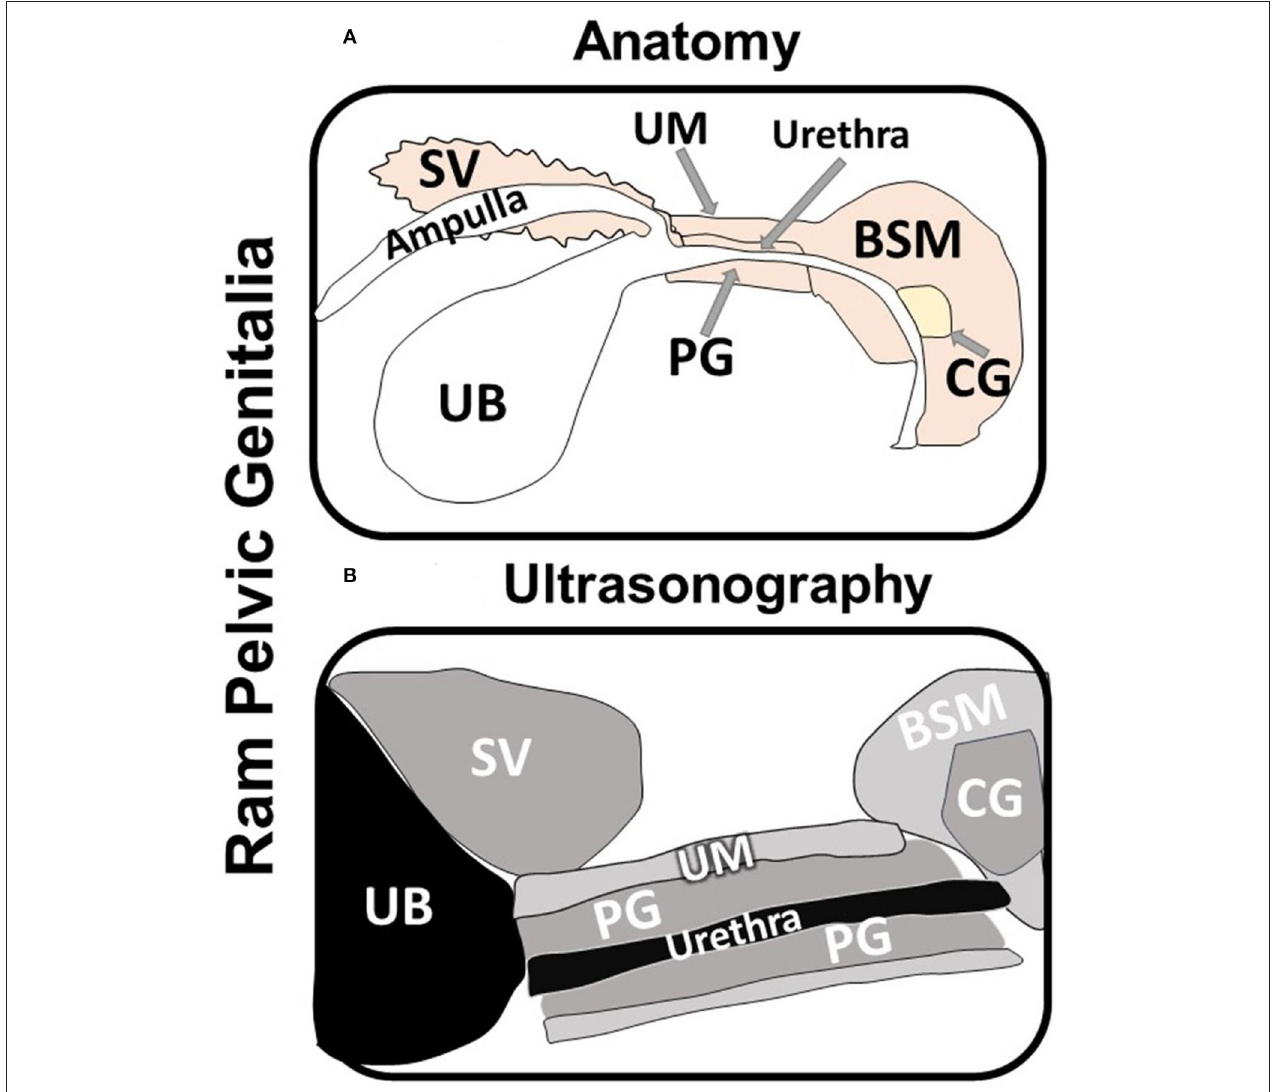
FIGURE 2 | Schematic diagram showing the anatomy (A) and the ultrasonography (B) of the ram intra-pelvic accessory genital glands; seminal vesicles (SV), Cowper’s glands (CG), and prostate gland (PG) in relation to the urinary bladder (UB; non-echogenic) and the bulbospongiosus muscle (BSM) and urethral muscle (UM). Note that the urethra appears as lumen with different echogenicity inside the prostate gland (B)